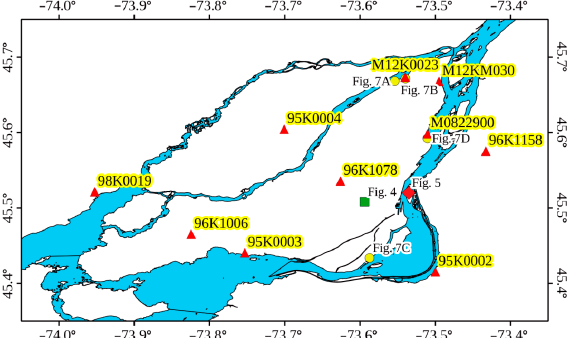
Fig. 1. Spatial distribution of the selected GPS points (red triangles) over the city of Montreal and the